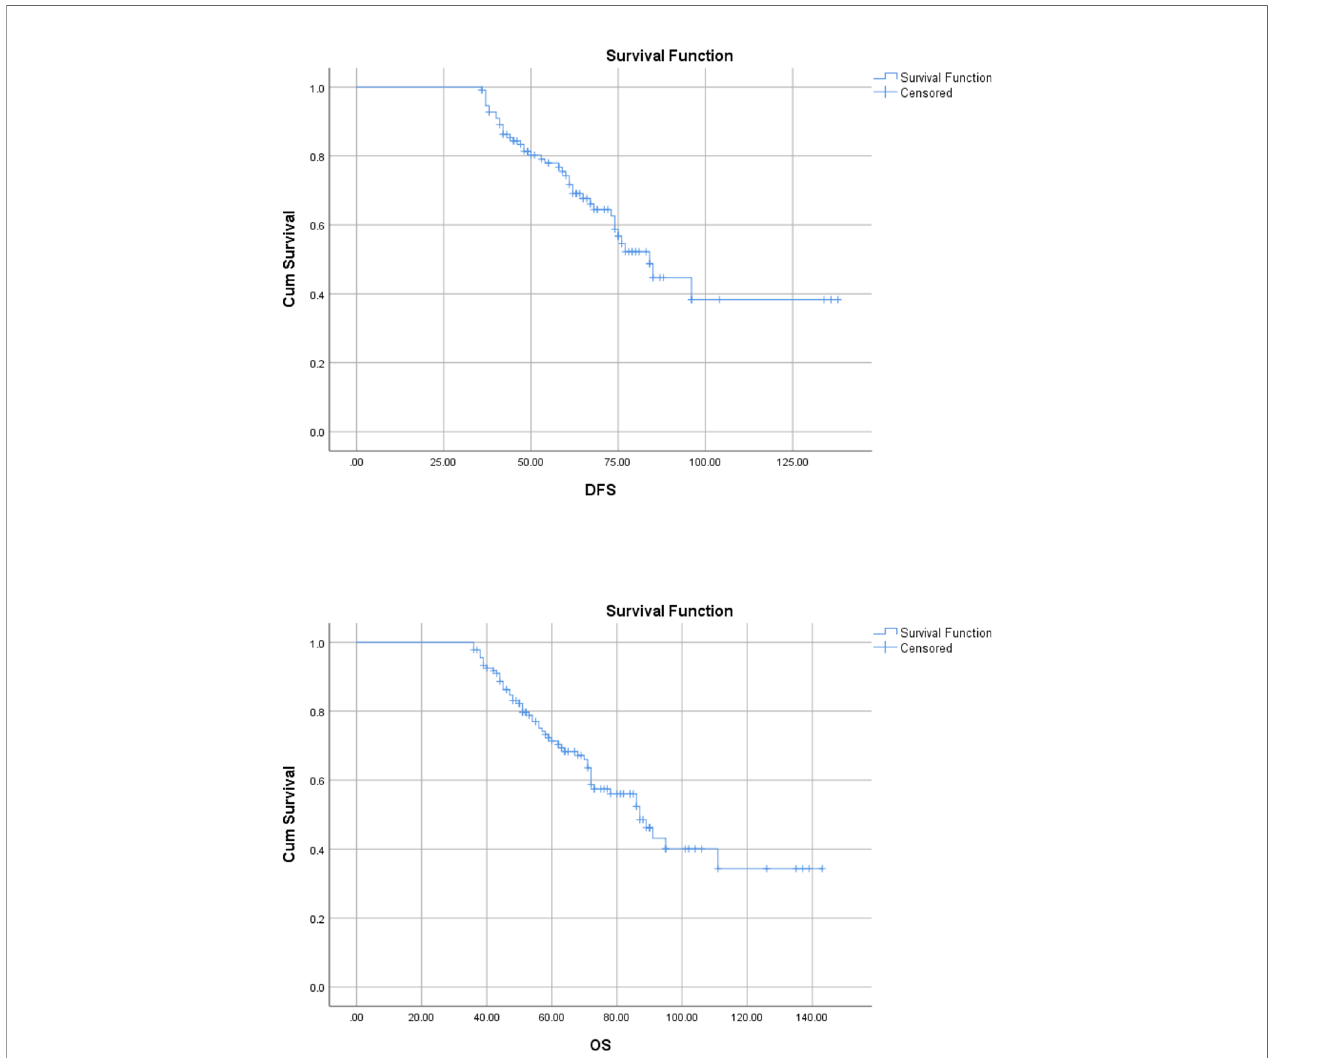
FIGURE 1 | Kaplan – Meier curve showing 3-year disease-free and overall